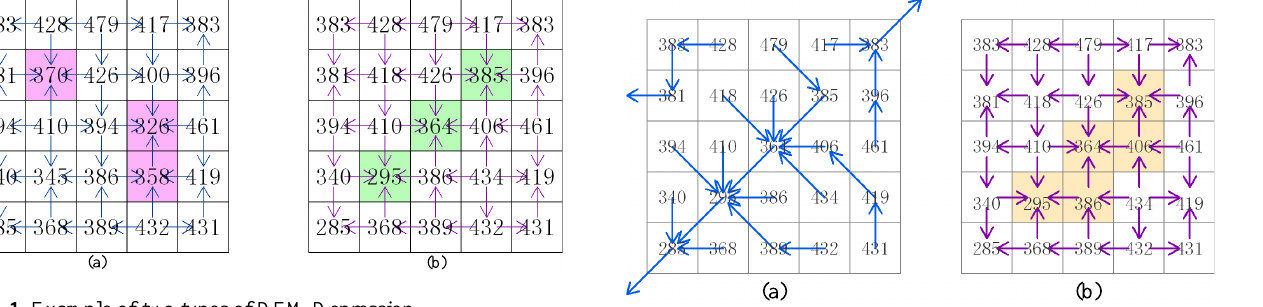
Fig. 1. Example of two types of DEM Depression.